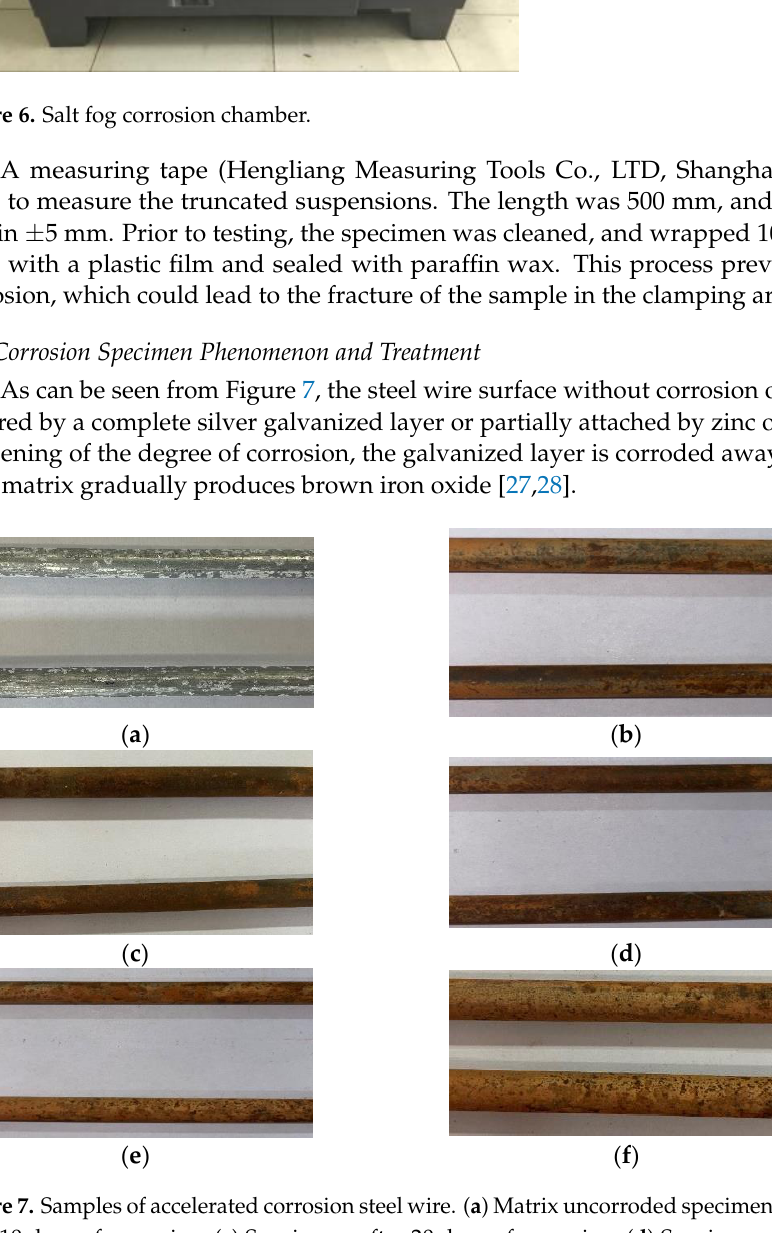
( f ) Figure 7. Samples of accelerated corrosion steel wire. ( a ) Matrix uncorroded specimens, ( b ) Speci- mens after 10 days of corrosion, ( c ) Specimens after 20 days of corrosion, ( d ) Specimens after 40 days of corrosion, ( e ) Specimens after 60 days of corrosion and ( f ) Specimens after 90 days of corrosion. Then, in order to control the reaction speed, the steel wire was derusted with a clean- ing solution mixed with dilute hydrochloric acid and hexamethylenetetramine [29]. The corroded samples were placed in a glass container, diluted with hydrochloric acid, soaked for 5 – 6 min, and then cleaned. The acid-washed high-strength steel wire was placed in a Ca(OH) 2 solution to neutralise the residual hydrochloric acid on the surface and then placed in clean water (not higher than 40 °C) to wash off the residual Ca(OH) 2 on the high- strength steel wire. Finally, the steel wire was dried, as shown in Figure 8. The quality loss